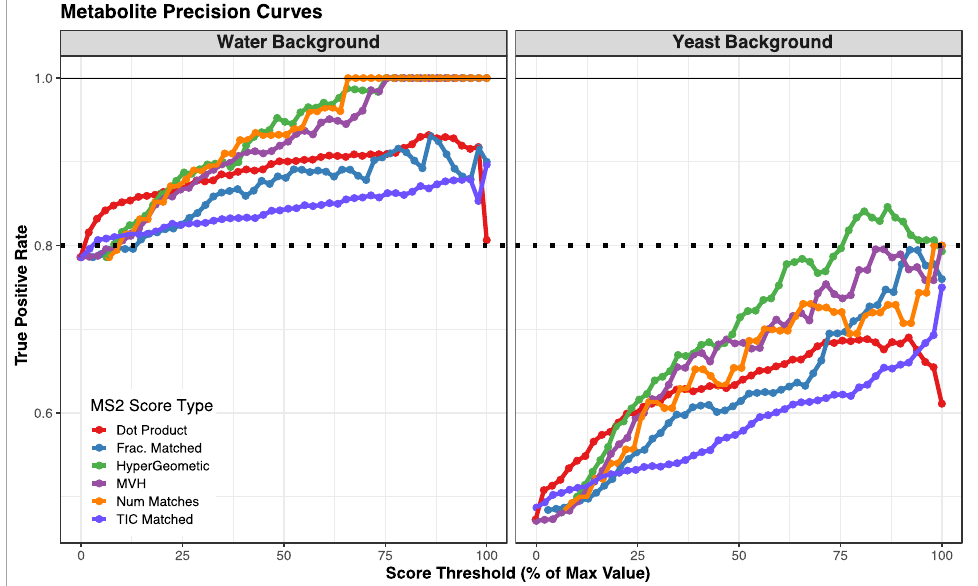
Figure 3. Metabolomics Spike-In Standards Precision Curve. True positive rate as a function of score threshold was assessed in either water or yeast backgrounds. At each threshold of MS/MS score we calculated the fraction of matches that were correctly matched (based on known retention time of spiked-in standards, see Figure S3). To allow for direct comparison between different scoring methods, the X-axis is scaled to the maximum value of each scoring method. As expected, precision was worse in the yeast background compared to the water background due to the presence of a higher number of background peaks. Performance of all methods improved with higher thresholds, with the hypergeometric score having the best performance (in terms of precision).